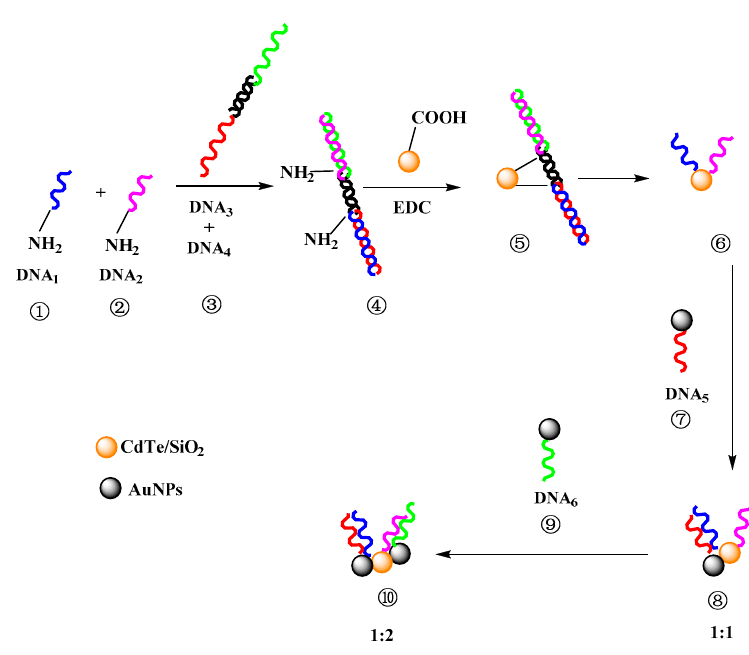
Figure 1. Controllable nanostructures of fluorescent DNA probes by DNA scaffolds (donor/acceptor ratio was 1:1 and 1:2, respectively).